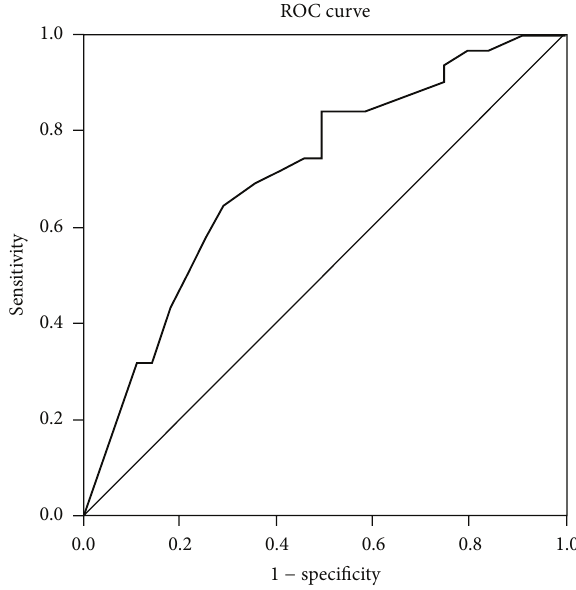
Figure 1: Receiver operating characteristic (ROC) curve for the variable time of the disease in the HT group, using infertility as the gold standard. AUC: 0.713; 95%CI: 0.5888–0.838; 𝑃 = 0.003 . Cut-off point: time of disease ≤ 6.5 years. Sensitivity 64.5%; specificity 71.4%.